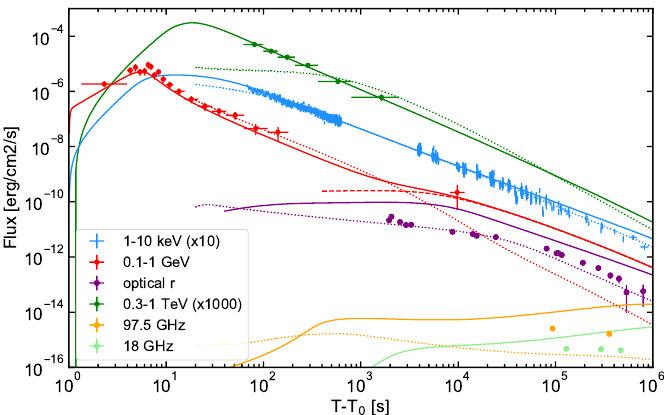
Figure 22. Modeling of broad band GRB190114C light curves. Description of the different modelings used is given in Section 4.3.3. From